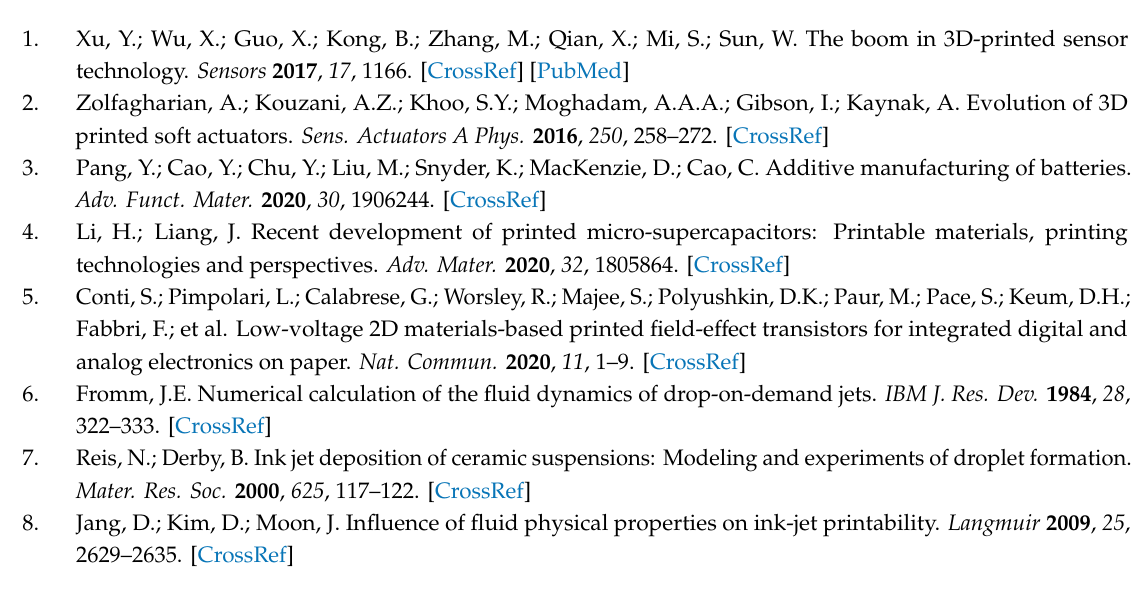
3 nanoparticles in